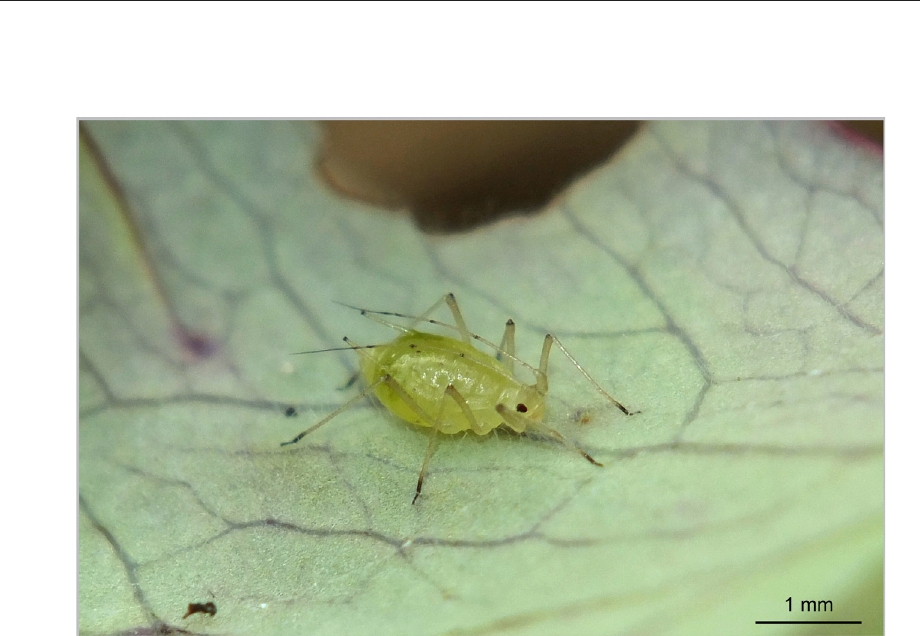
Fig. 25. Aulacorthum (Aulacorthum) solani (Kaltenbach, 1843). Aptera on Aquilegia vulgaris L. (Ranunculaceae).